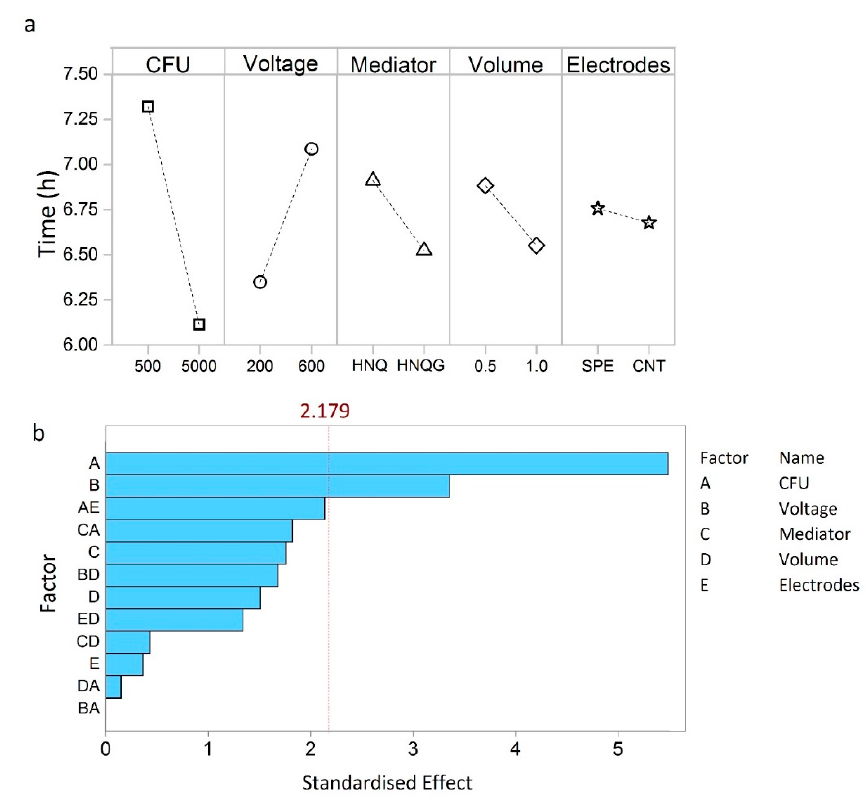
Figure 2. Main effects plot ( a ) showing which factors have the greatest effects on detection time. Pareto chart ( b ) showing the most significant factors and interactions. The dotted line indicates the standardized effect cut off value (2.179), factors having an effect below this do not contribute significantly to detection time.